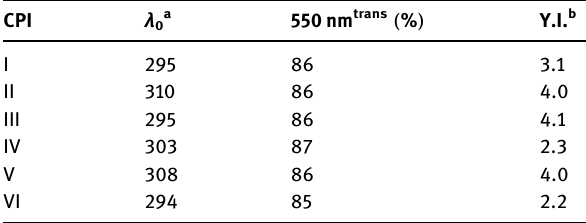
Table 4: Mechanical properties of CPI fi lms obtained from the CHDA monomer